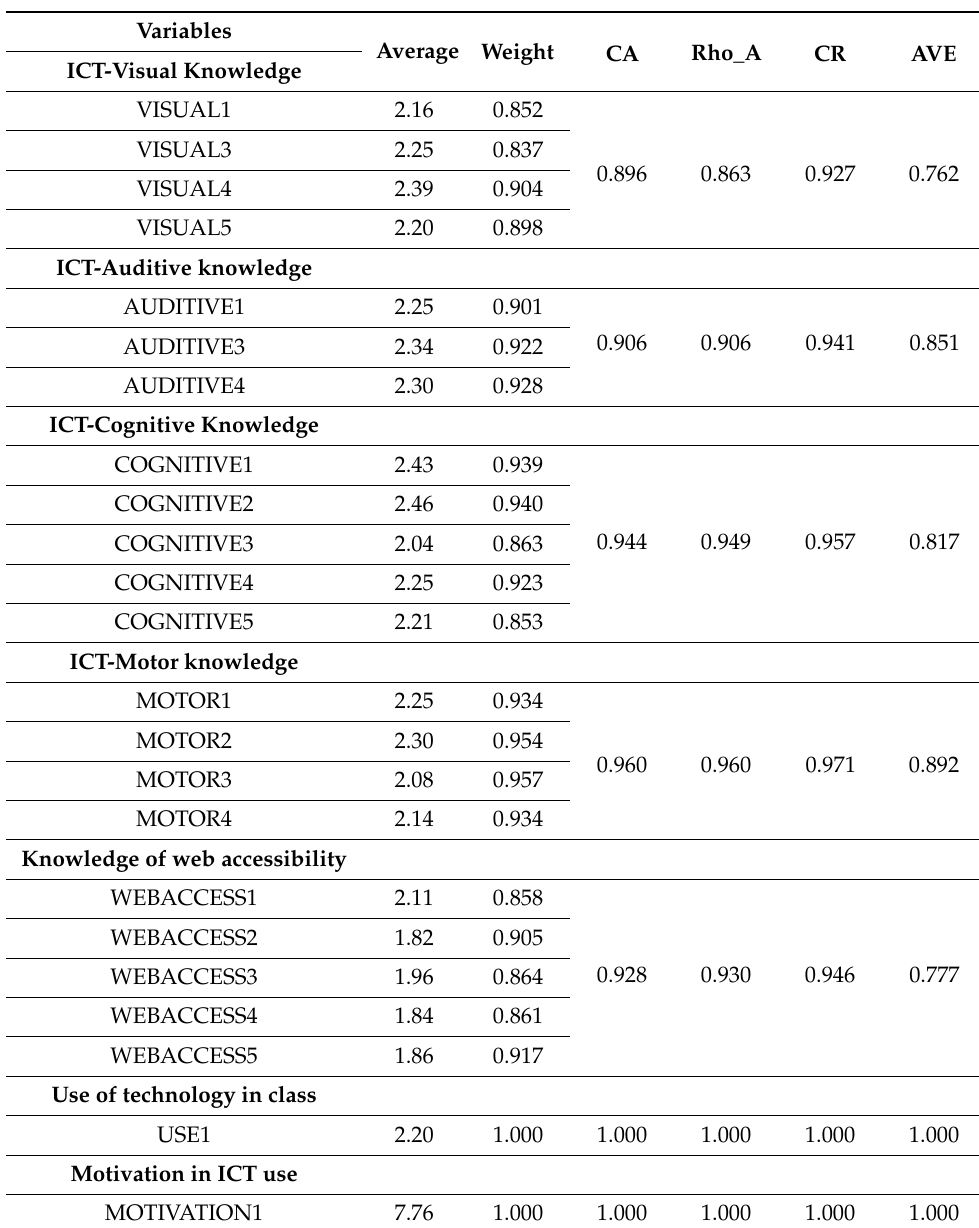
Table 2. Reliability and convergent validity of the